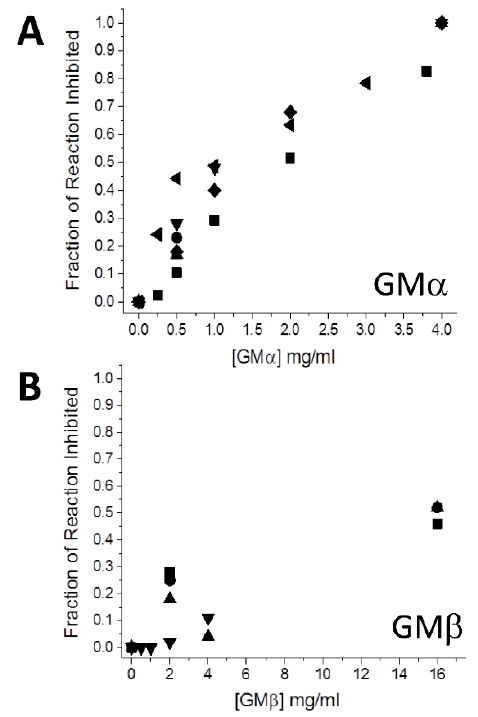
Figure 1. Colorimetric starch–iodine assay. The effectiveness of GM α ( A ) and GM β ( B ) to inhibit starch hydrolysis (1 mg/mL) mediated by porcine pancreatic α -amylase (1 µ M) is shown as a function of the concentration of GM α and GM β . The assay was performed essentially as reported by Xiao et al. [21]. A total of 100 µ L of 1 mg/mL (or 5 mg/mL) of soluble starch ± various concentrations (0.5 mg/mL up to 16 mg/mL) of GM α or GM β were incubated for 20 min at 30 ◦ C ± 5 µ L enzyme, for a total concentration of 1 µ M amylase/well. Assays were performed at 0.5, 1, 2, and 4 mg/mL of the GMs, Acarbose at 400 µ M, and starch at 1 mg/mL or 5 mg/mL. At the end of the reaction time, the absorbance was read at 562 nm. The fraction of the reaction inhibited was calculated using U/mL values determined from the iodine–starch assay as described by Xiao et al. [21], with U/mL = (A 562 control − A 562 sample)/(A 562 starch × 20 min × 0.1 mL reaction volume), a value that can be interpreted as mg of starch hydrolyzed per minute. U/mL values shown are averages of 4 or 5 separate experiments, each done in triplicate. Solution conditions are 20 mM potassium phosphate, pH 7, 30 ◦